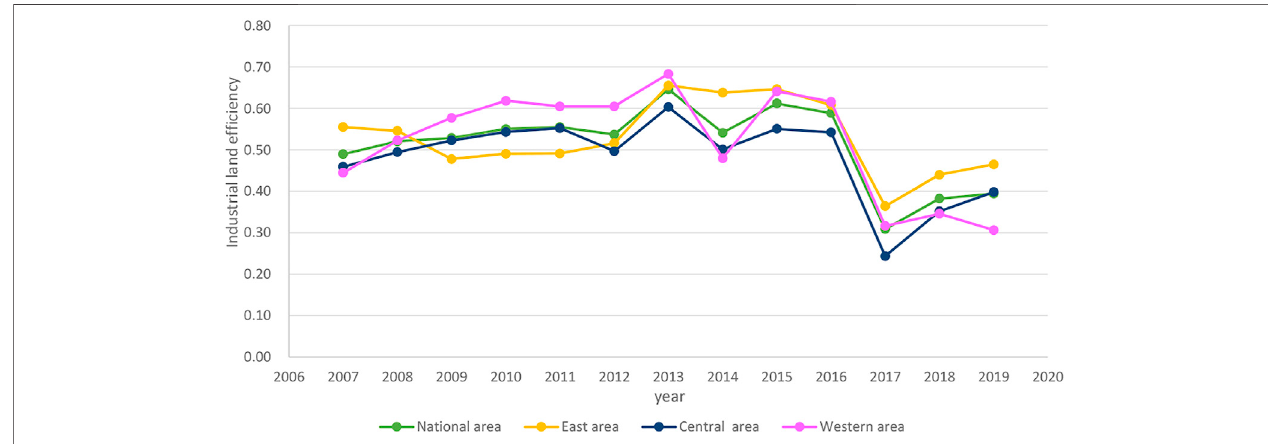
FIGURE 5 | The average change of urban ILUE in